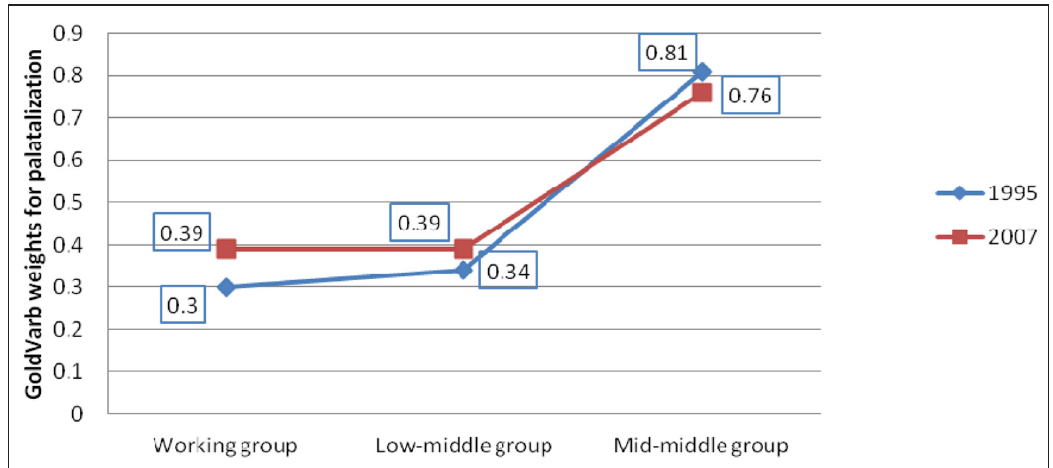
Figure 5: Comparison of rates of palatalization of dental stops followed by /i/ according to socioeconomic status in UP.